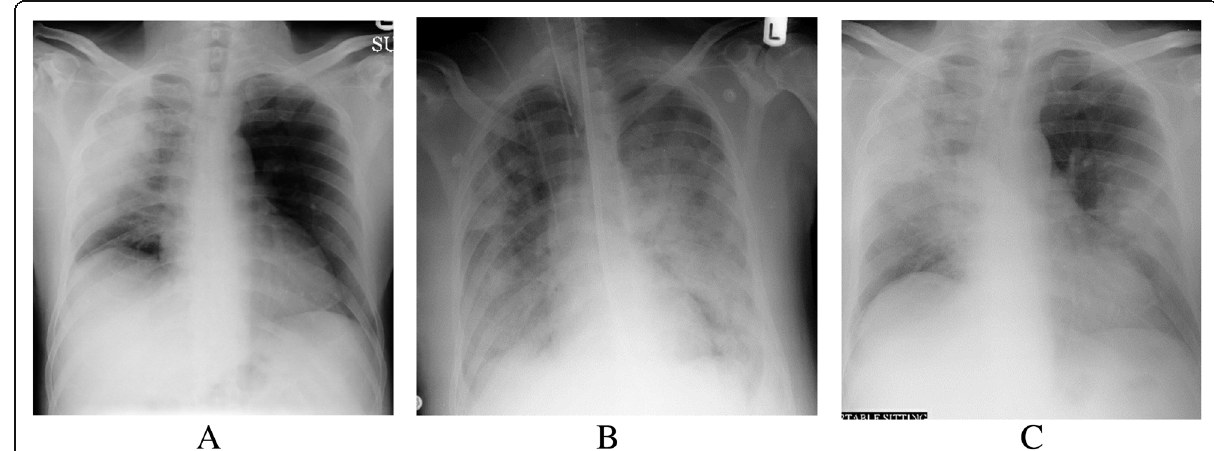
Fig. 1 A 65-year-old man with Middle East respiratory syndrome coronavirus. Serial chest radiographs show a type 4 pattern of progression. A A frontal radiograph shows an ill-defined ground-glass opacity occupying the right upper and mid-zone in the peripheral location. B A follow-up radiograph after 3 days shows the bilateral ground-glass type of opacities with a further increase of the right opacity. C A follow-up radiograph after 5 days shows a further extension of the bilateral opacities with the development of consolidation in the left side along with effusion. The patient died on day 8 in the